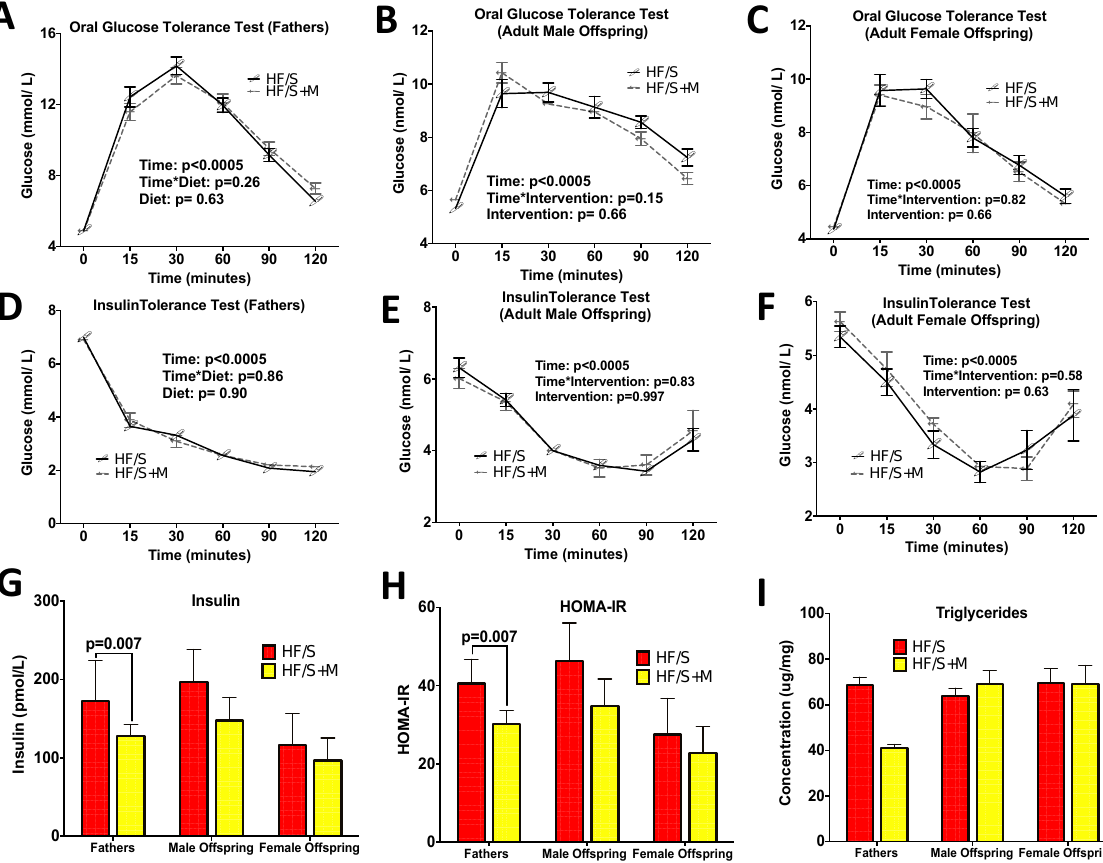
Figure 2. OGTT, ITT, Fasted Insulin, HOMA-IR and Hepatic Triglyceride Concentrations. The oral glucose tolerance test (OGTT) of ( A ) fathers, ( B ) adult male offspring and ( C ) adult female offspring. The insulin tolerance test (ITT) of ( D ) fathers, ( E ) male offspring, ( F ) female offspring. ( G ) Insulin levels, ( H ) Homeostatic Model Assessment of Insulin Resistance (HOMA-IR), ( I ) triglyceride content in hepatic tissue. The values are means ± SEM, n = 8–13. In adult offspring, there was a significant sex effect in the overall model for OGTT ( p = 0.0001), ITT ( p = 0.003), insulin ( p = 0.0001), HOMA-IR ( p = 0.0001). Triglyceride sex effect was not significant. Since most assessments in adult offspring had a significant sex effect, subsequent analysis was performed in males and females